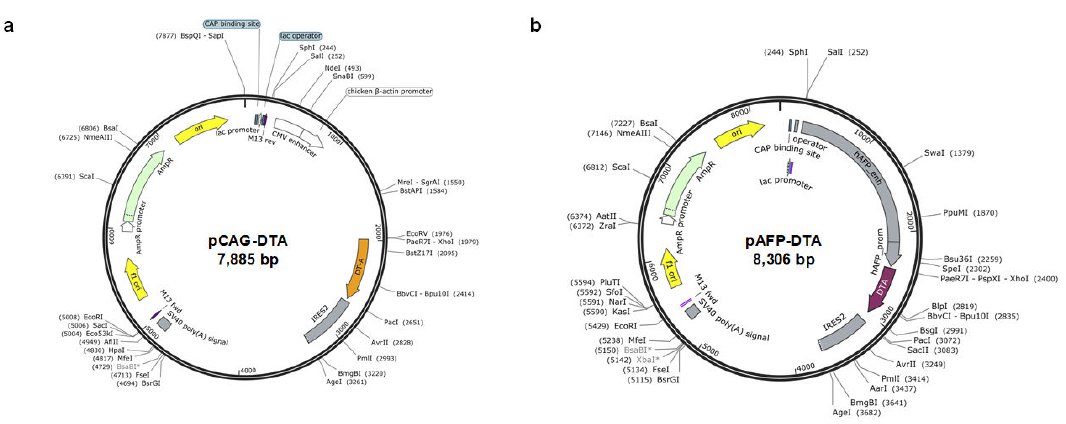
Figure 1. Development of diphtheria toxin fragment A (DTA)-expressing plasmid. The DTA expression vector, containing ( a ) a chicken β -actin promoter, cytomegalovirus enhancer, and an internal ribosome entry site (IRES) (pCAG–DTA), and ( b ) a human alpha-fetoprotein (AFP) promoter, cytomegalovirus enhancer, and an IRES